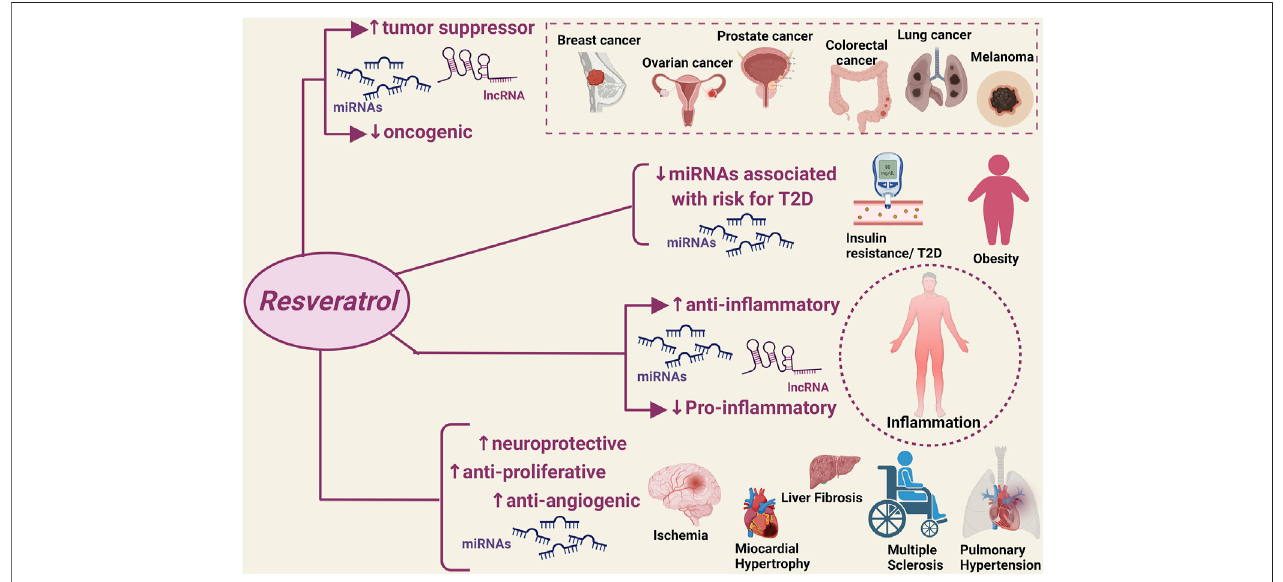
FIGURE 1 | Modulatory effect of resveratrol on disease-associated non-coding RNAs. miRNAs, micro RNA; lncRNA, non-coding RNAs. ↑ : increased expression/ activity; ↓ : decreased expression/activity.